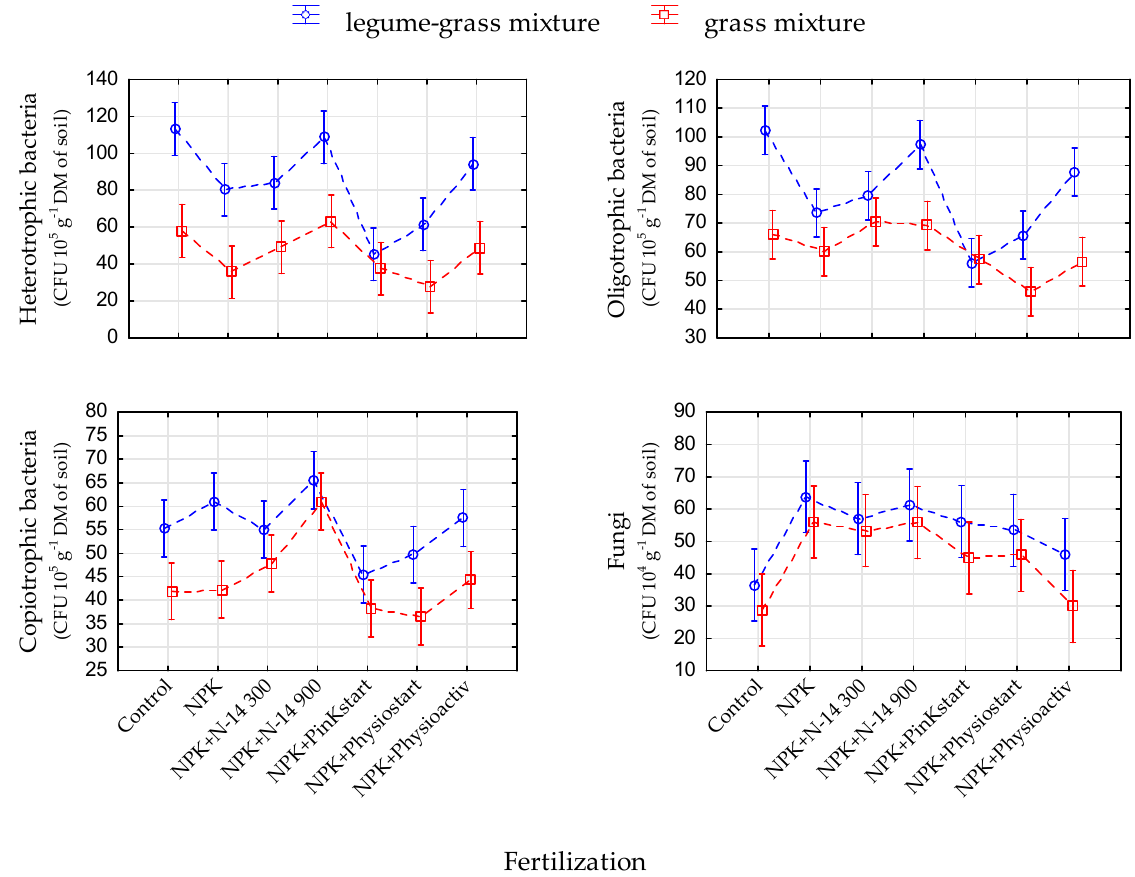
Figure 6. Count of soil microorganisms in 2018–2019 (estimated marginal means and 95% confidence intervals in each experimental combination).